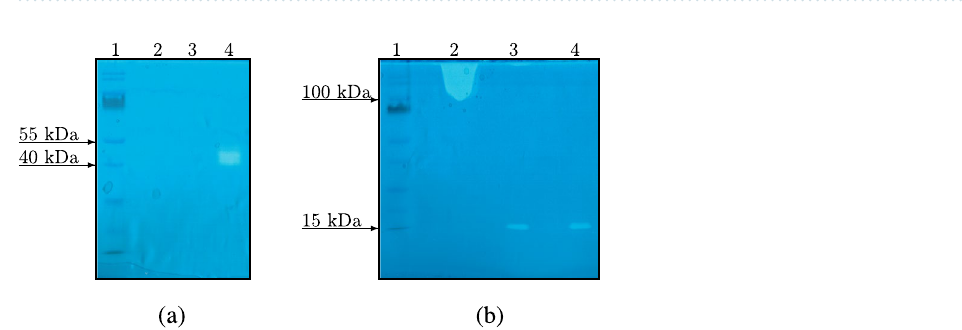
Figure 4. Zymogram in polyacrylamide gel containing HA as a substrate: ( a )—HPC homogenate (1—protein marker, 2—homogenate after heating in the loading buffer, 3—homogenate after heating in the loading buffer without DTT, 4—homogenate in buffer with DTT without warming up), ( b )— S. hyalurolyticus lyase (1—protein marker, 2—after warming up in buffer without DTT, 3—after warming up in buffer with DTT, 4—hyaluronidase in buffer with DTT without warming up). Protein marker PageRuler Prestained Protein Ladder: 180, 130, 100, 70, 55, 40, 35, 25, 15, 10 kDa. The samples were being heated in the loading buffer for 5 min at 95